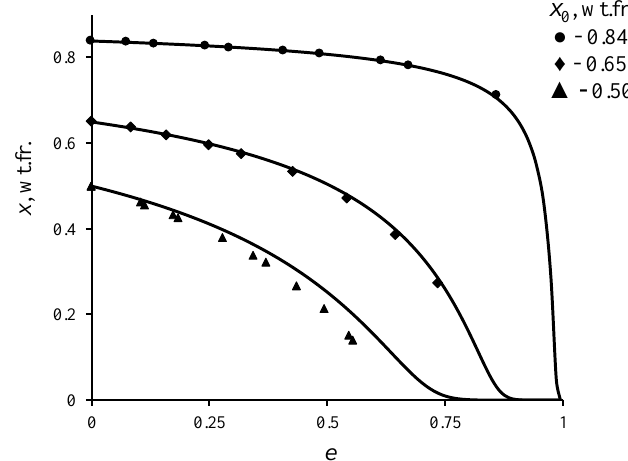
Figure 7. Change in the concentration of ethanol in the ethanol–water liquid mixture during open evaporation: line is solution (3); geometric figures—experimental data.